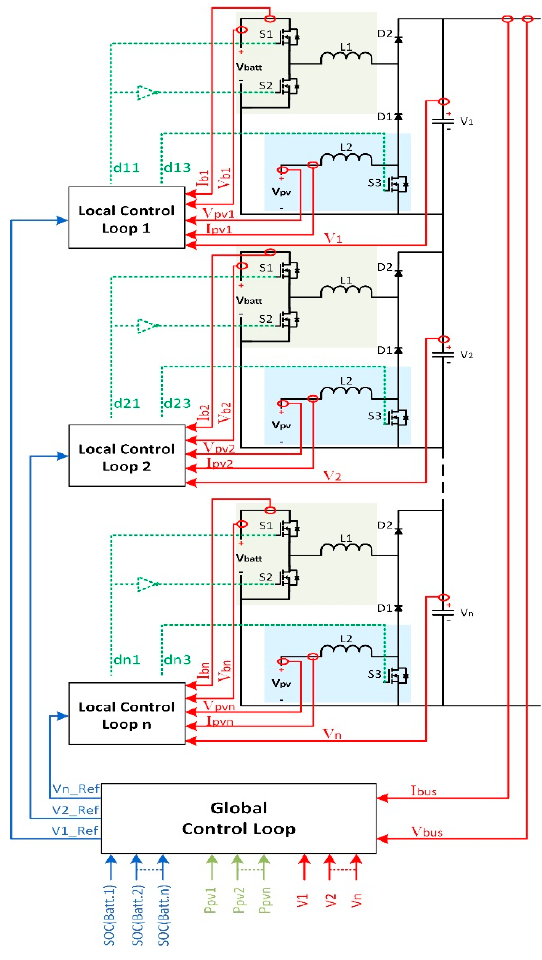
Figure 8. Block diagram of the proposed MMPC.